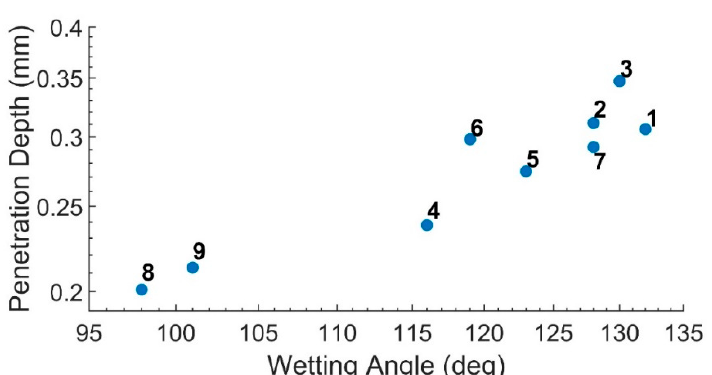
Figure 7. The relation between welding current, travel speed, welding feed rate (WFR), and weld width for Inconel 718 single-pass samples.